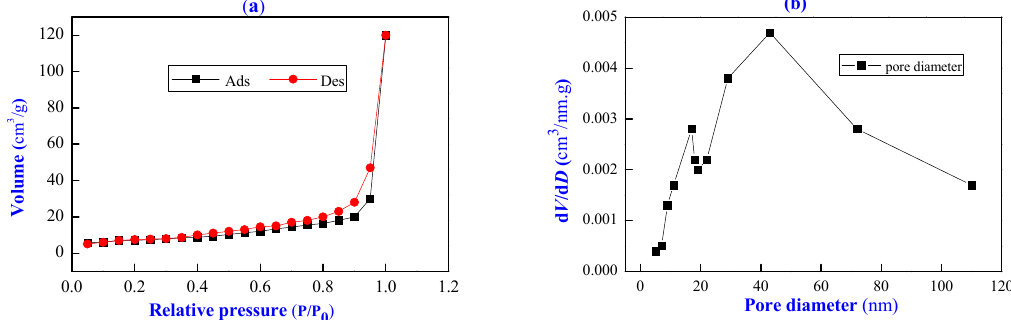
Figure 4. N 2 adsorption / desorption isotherms ( a ) and pore size distribution ( b ) curves of COOH-PIL@P-POM (FW = 23,000).